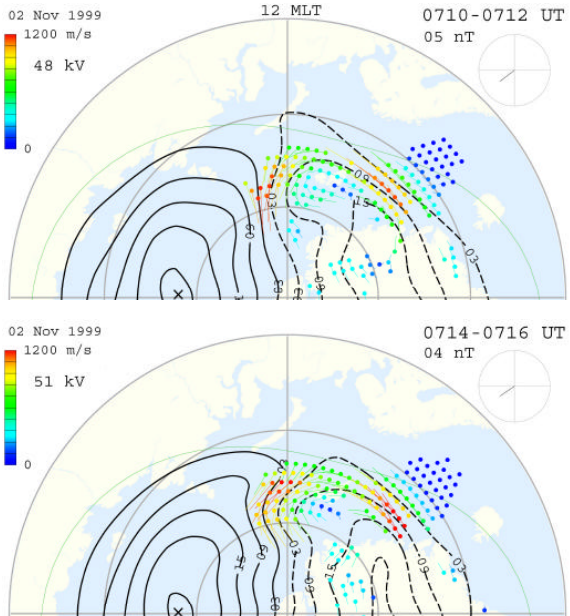
Fig. 9. The dayside portions of convection maps (centered at 12:00 MLT). The fitted convection velocity vectors are colour- coded. Contours (solid and dashed) of the electrostatic potential are shown with the value of the cross-polar cap potential difference given (top-left). The IMF B z vs. B y clock-dial plot is shown (top-